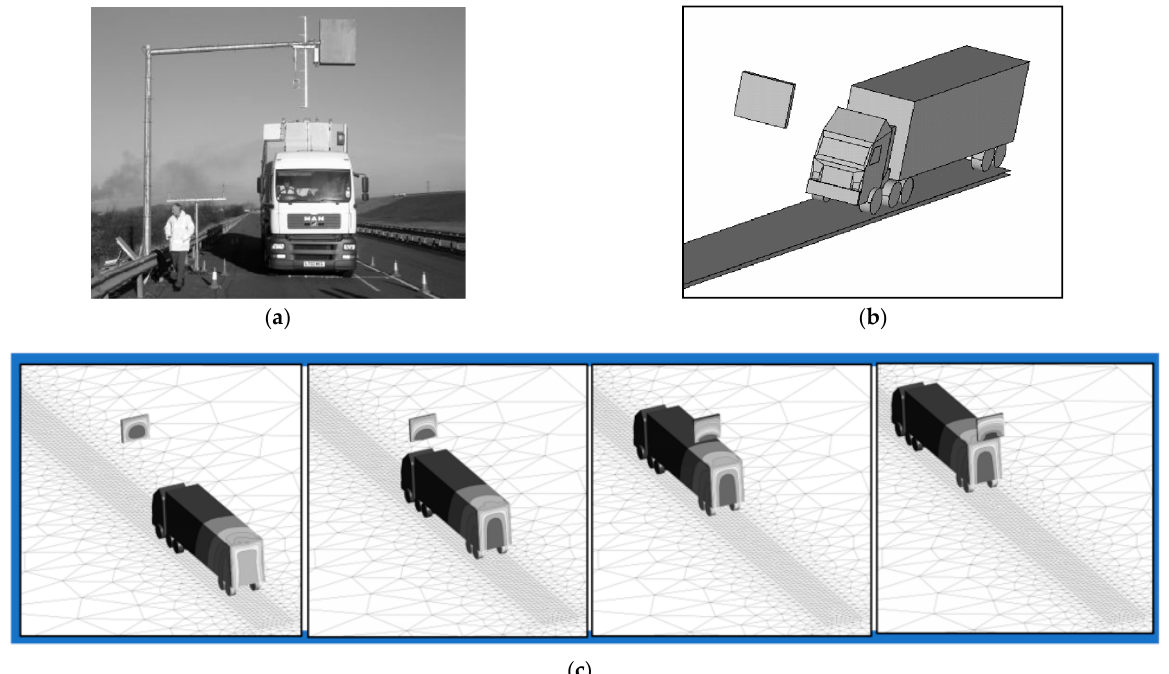
Figure 8. ( a ) Filed study setup (HSV and signal box cantilever gantry, [38]); ( b ) simplified HSV model with its signal box; and ( c ) snapshots of HSV passage simulation under the signal